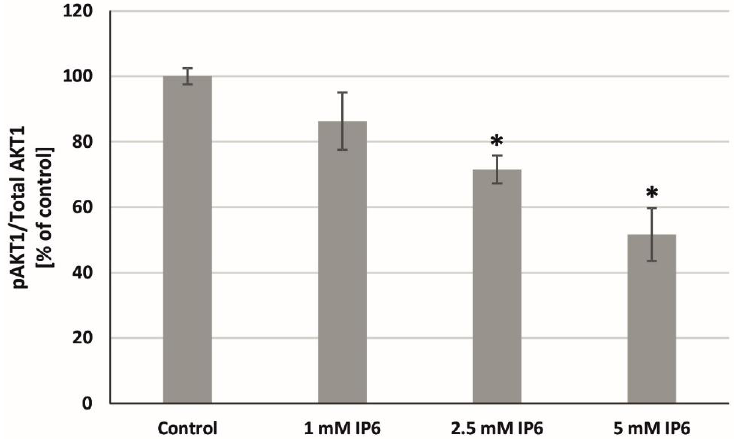
Figure 7. Effect of InsP6 at concentrations of 1, 2.5 and 5 mM on the AKT1 activity in Caco-2 cells at 24 h. The results are presented as mean ± SD of three separate experiments; * p < 0.05 vs. control. 2.8. The Influence of InsP6 on p70S6K Activity in Caco-2 Cells